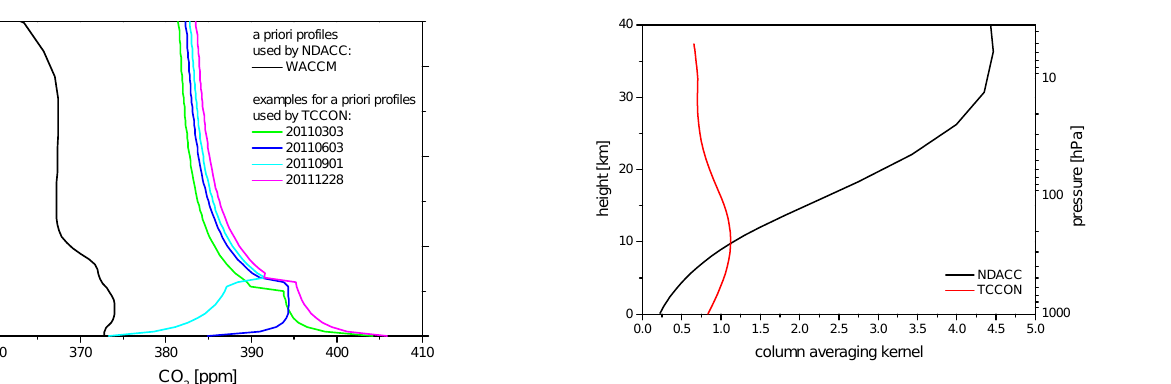
Figure 3. A priori profiles for Karlsruhe: WACCM v6 (used as a Fig. 3. A priori profiles for Karlsruhe: WACCM v6 (used as a pri- priori for NDACC retrieval) and some examples used as a priori for ori for NDACC retrieval) and some examples used as a priori for Fig. 3. A priori profiles for Karlsruhe: WACCM v6 (used as a pri- TCCON retrieval. TCCON retrieval. ori for NDACC retrieval) and some examples used as a priori for TCCON retrieval.